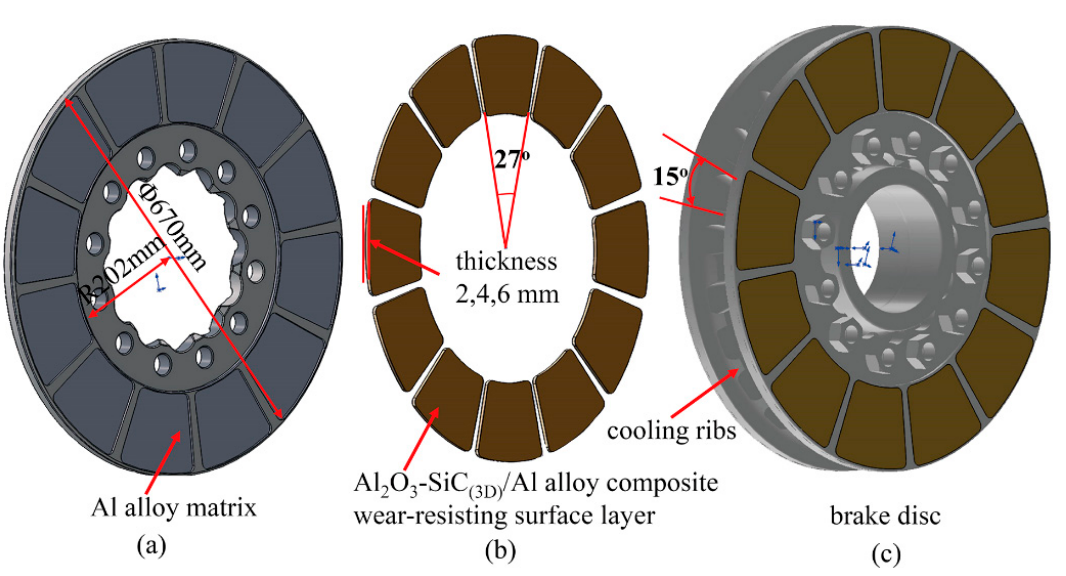
Figure 1. 3D brake disc model for calculation: ( a ) Al alloy matrix of brake disc; ( b ) Al 2 O 3 -SiC (3D) / Al alloy composite wear-resisting surface layer, thickness 2, 4, and 6 mm; ( c ) Al alloy brake disc.